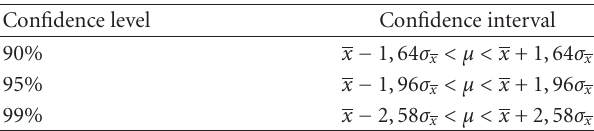
Table 2: Confidence interval determination according to a confi- dence level.